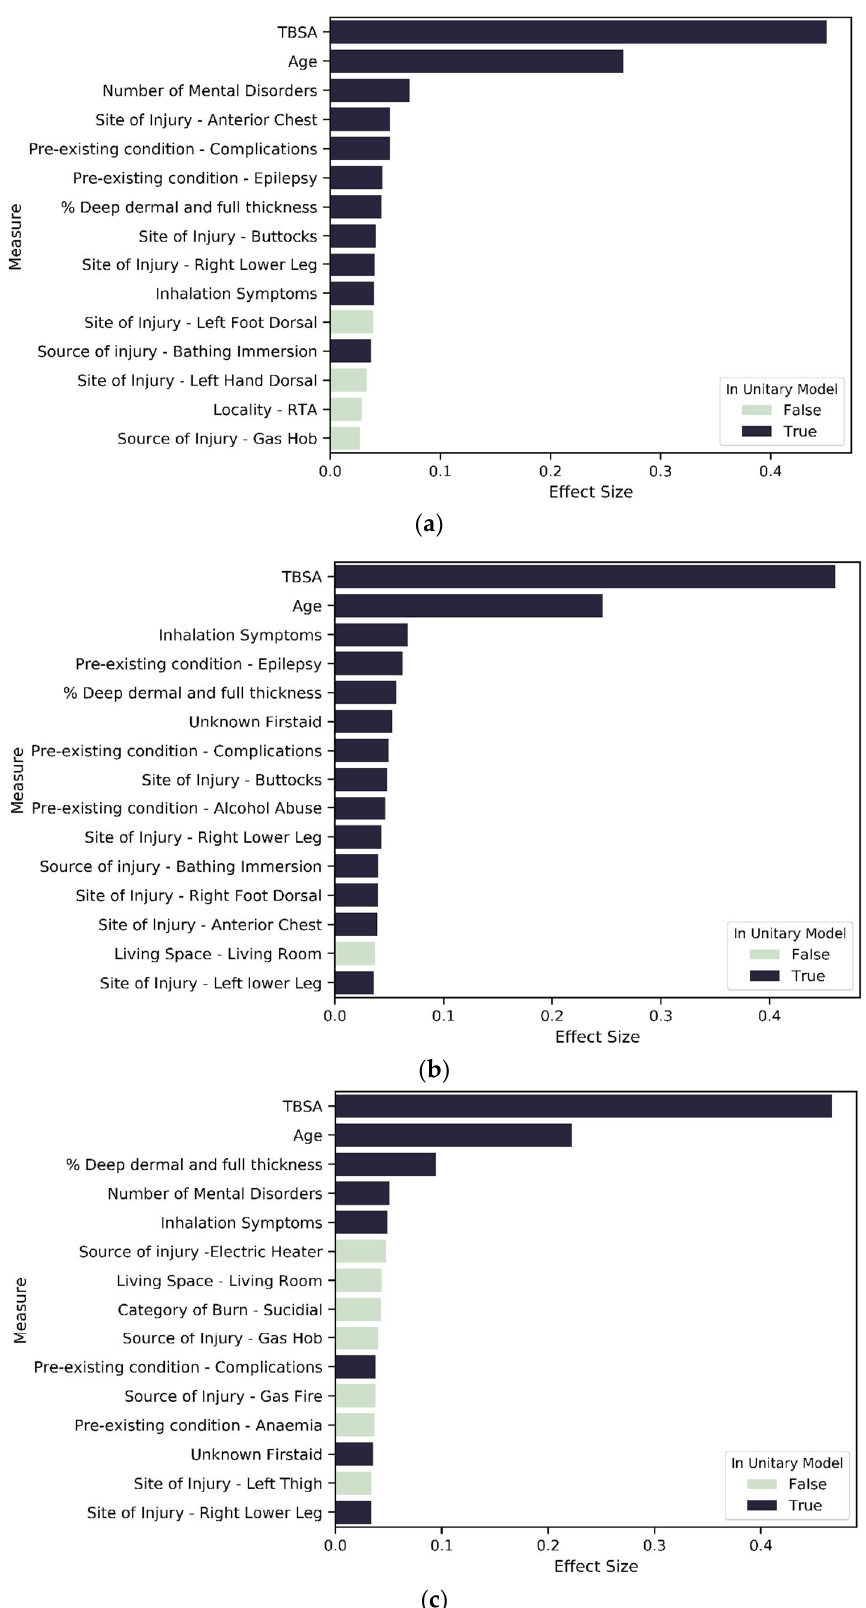
Figure 8. Variables of importance: ( a ) top 15 contributors from 196 significant variables in SES1; ( b ) top 15 contributors from 188 significant variables in SES2; ( c ) top 15 contributors from 137 significant variables in SES3.